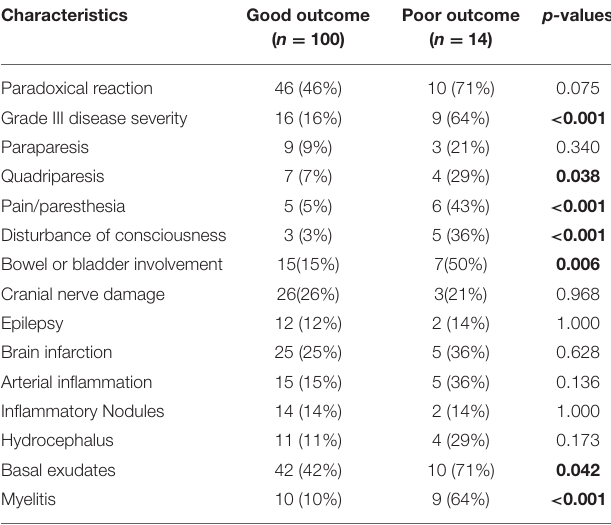
TABLE 3 | Clinical and neuromaging characteristic of poor or good